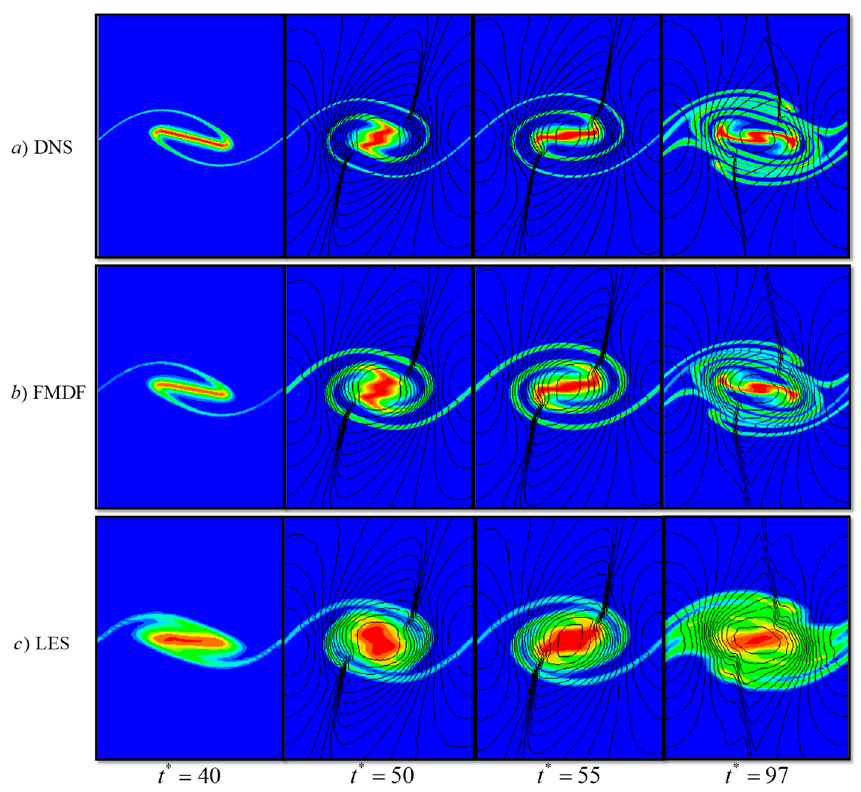
Figure 2. Four snapshots of mass fraction of product showing the evolution of the compressible mixing layer, when M c = 0.8. The results are calculated by ( a ) DNS, ( b ) LES-FMDF and ( c ) LES. The problem of LES overestimation of the mixture is more evident in the mean of the total product mass fraction as shown in Figures 3 and 4. Before t ∗ = 20, when the vortex has not been rolled up, the results of LES shows a strong mixing occurring near the mixing layer. In contrast, the changes in the total product mass fraction predicted by the FMDF are in good agreement with those predicted by DNS over a long period.